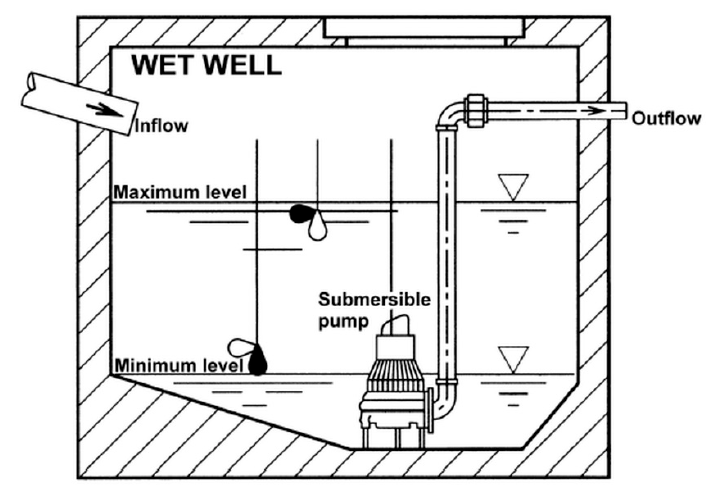
Figure 1. Sketch of the wet well of the pumping station with a single submersible pump [22].